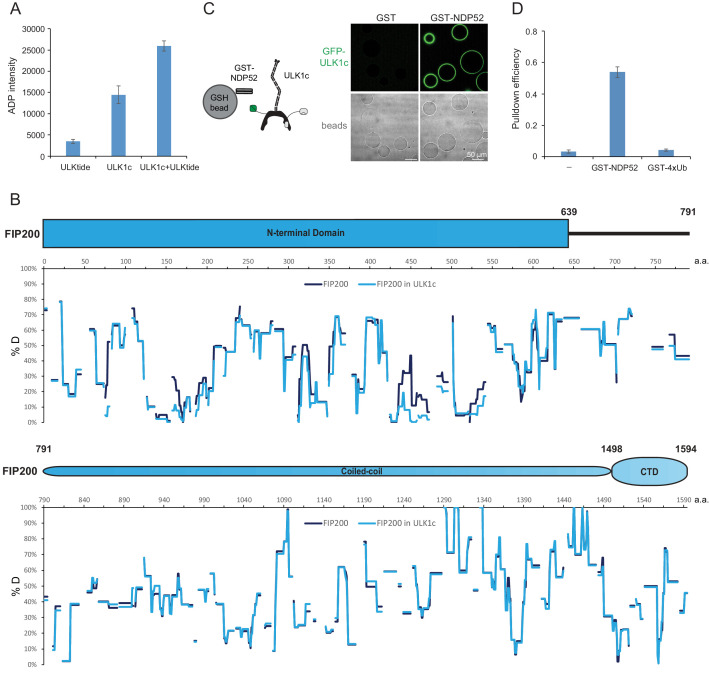
Purified ULK1 complex is functional.(A) ADP-Glo Kinase assay of ULK1 complex with ULKtide as substrate. N = 5 biological replicates. All values are mean ± SD. (B) Hydrogen Deuterium Exchange percentages of the FIP200 alone (Purple) and in FIP200:ATG13:ATG101:ULK1 (Blue) at 60 s time point. (C) Microscopy-based bead protein interaction assay with glutathione sepharose beads coated with GST-NDP52 as baits and incubated with GFP-tagged wild type ULK1 complex. Representative confocal micrographs are shown. Scale bars, 50 µm. (D) Pull-down efficiency of GFP-tagged wild type ULK1 complex by glutathione sepharose beads coated with GST-NDP52 or GST-4xUb as baits. N = 3 biological replicates. All values are mean ± SD.Figure 1—figure supplement 2—source data 1.Source data for graphs in Figure 1—figure supplement 2.